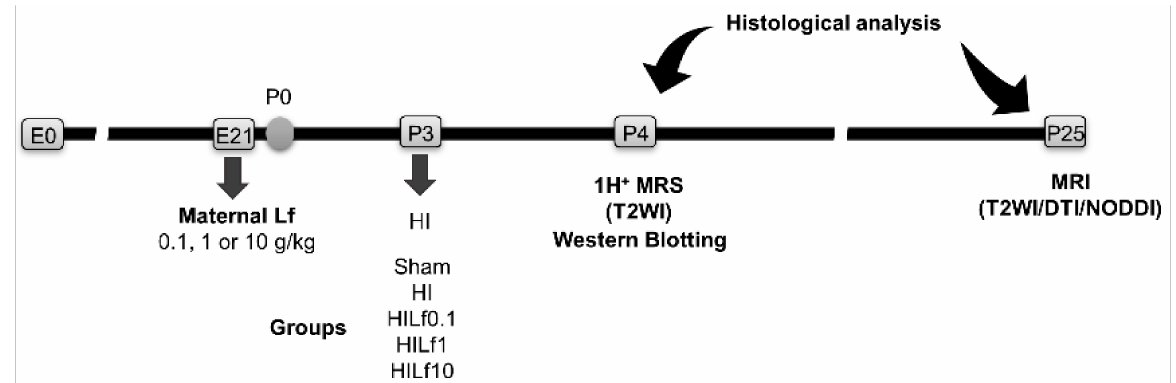
Figure 1. Experimental timeline of the study. Embryonic day (E). HI—hypoxia–ischemia. P, postnatal day. DTI, diffusion tensor imaging. Lf—lactoferrin. NODDI, neurite orientation dispersion and density